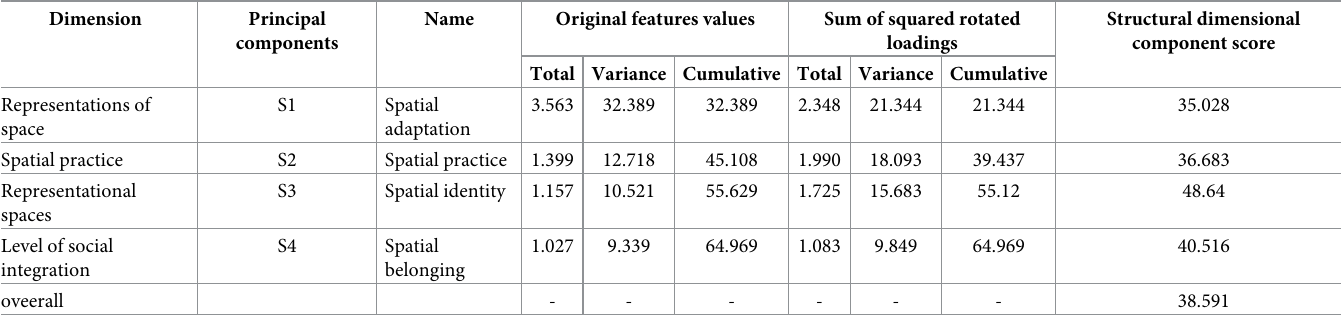
Table 4. Extraction results of main factors of social integration of ecological migrants in Yinchuan.